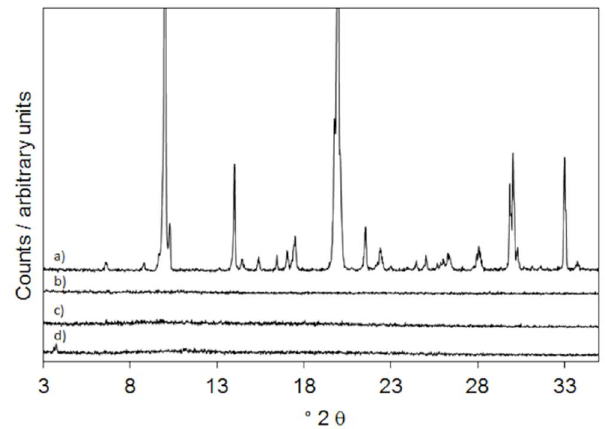
Figure 5. XRPD patterns of firocoxib ( a ), PVP:SOL (1:1) ( b ), F:PVP:SOL (1:2:2) ( c ), and F:PVP:SOL (1:4:4) ( d ).